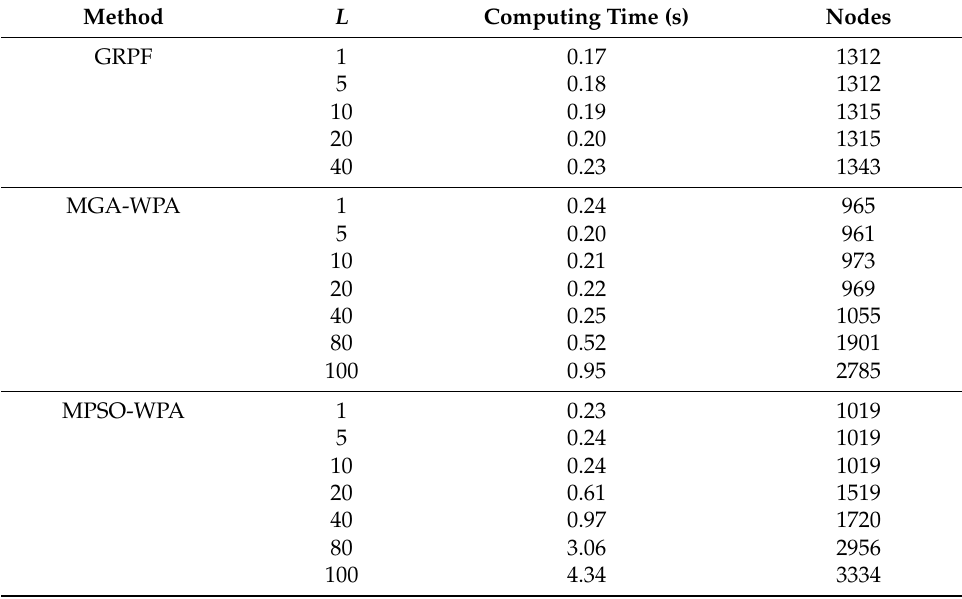
Table 2. Computing times and numbers of generated nodes in stability tests of considered high-order systems.